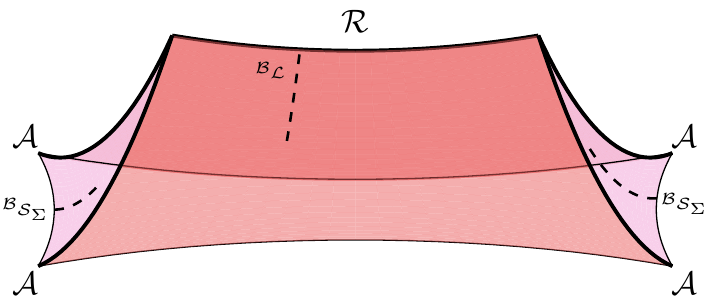
Figure 8. The cusp structure of a generic null membrane. The two lightsheets that form the lift meet at a spacelike ridge R . The lift and slope meet at four spacelike seams A . The ridge and the seams are marked with heavy curves. The lift and slope may each have cusps formed from collisions of null generators, marked B L and B S , respectively. These cusps extend down from the (cid:6) ridge along the lift, and up from the contradiction surface along the slope. They are marked here with dashed